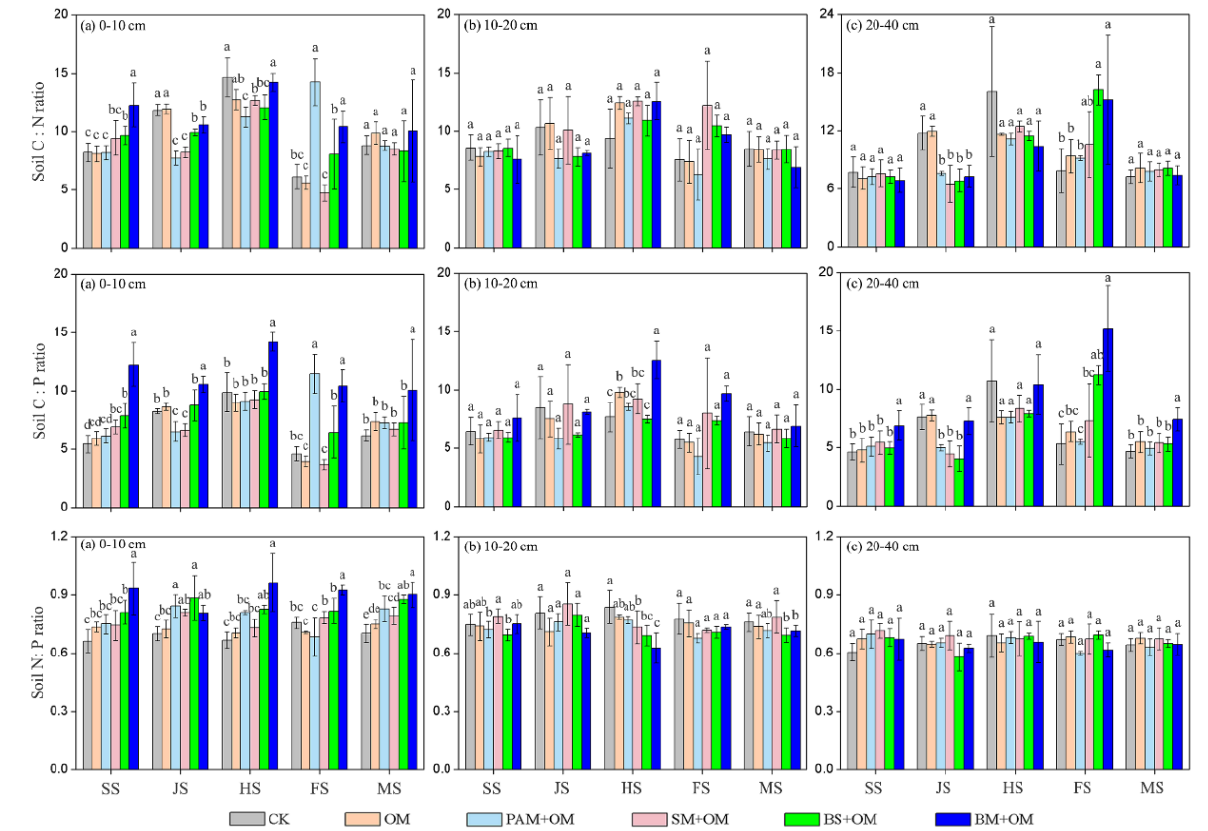
Figure 4. Dynamics of soil C/N, C/P, and N/P under different oat growth stages in 0–10 cm ( a ), 10–20 cm ( b ), and 20–40 cm ( c ). SS: seedling stage; JS: jointing stage; HS: heading stage; FS: filling stage; MS: maturation stage. Values are means of three replicates ± SD; error bars refer to standard deviation; values having different lowercase letters on the bars indicate significant differences among different treatments (LSD, p < 0.05).